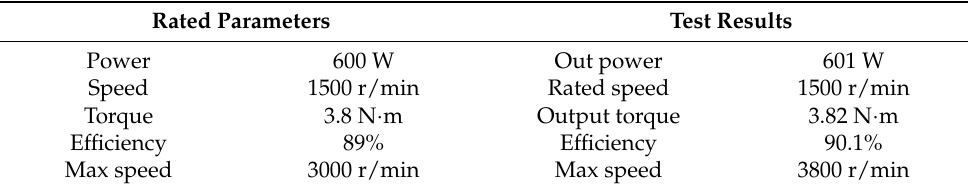
Table 1. The rated parameters and test results. Rated Parameters